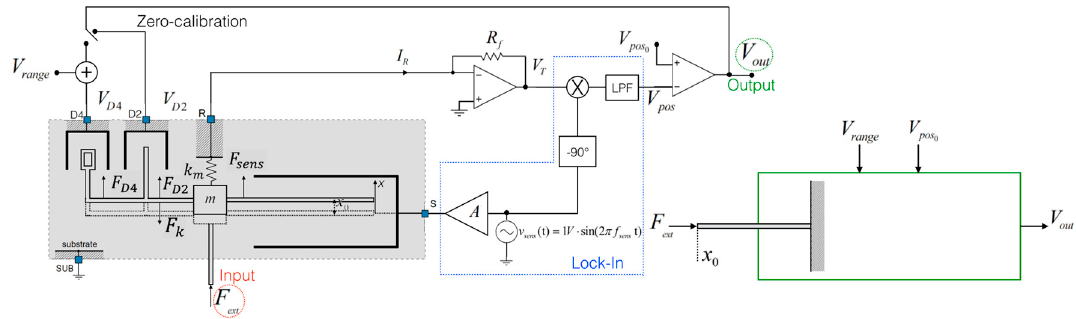
Figure 1. Block diagram of the servo-assisted position-feedback MEMS force